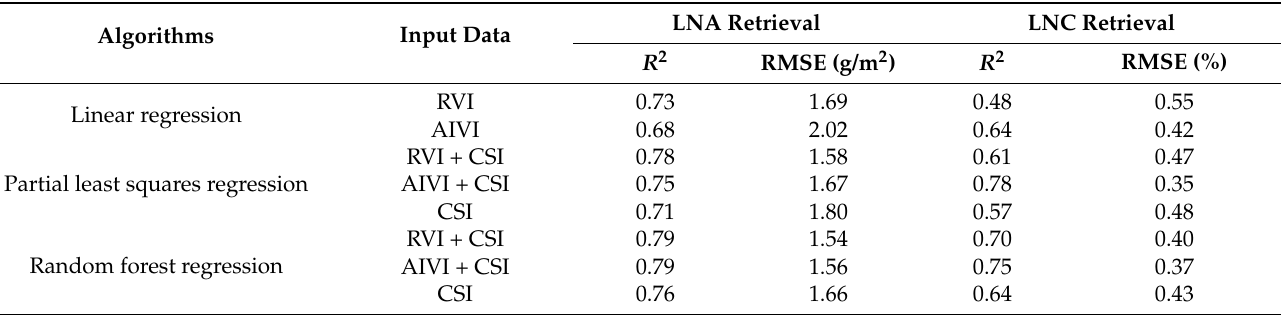
Table 2. Prediction accuracy of different